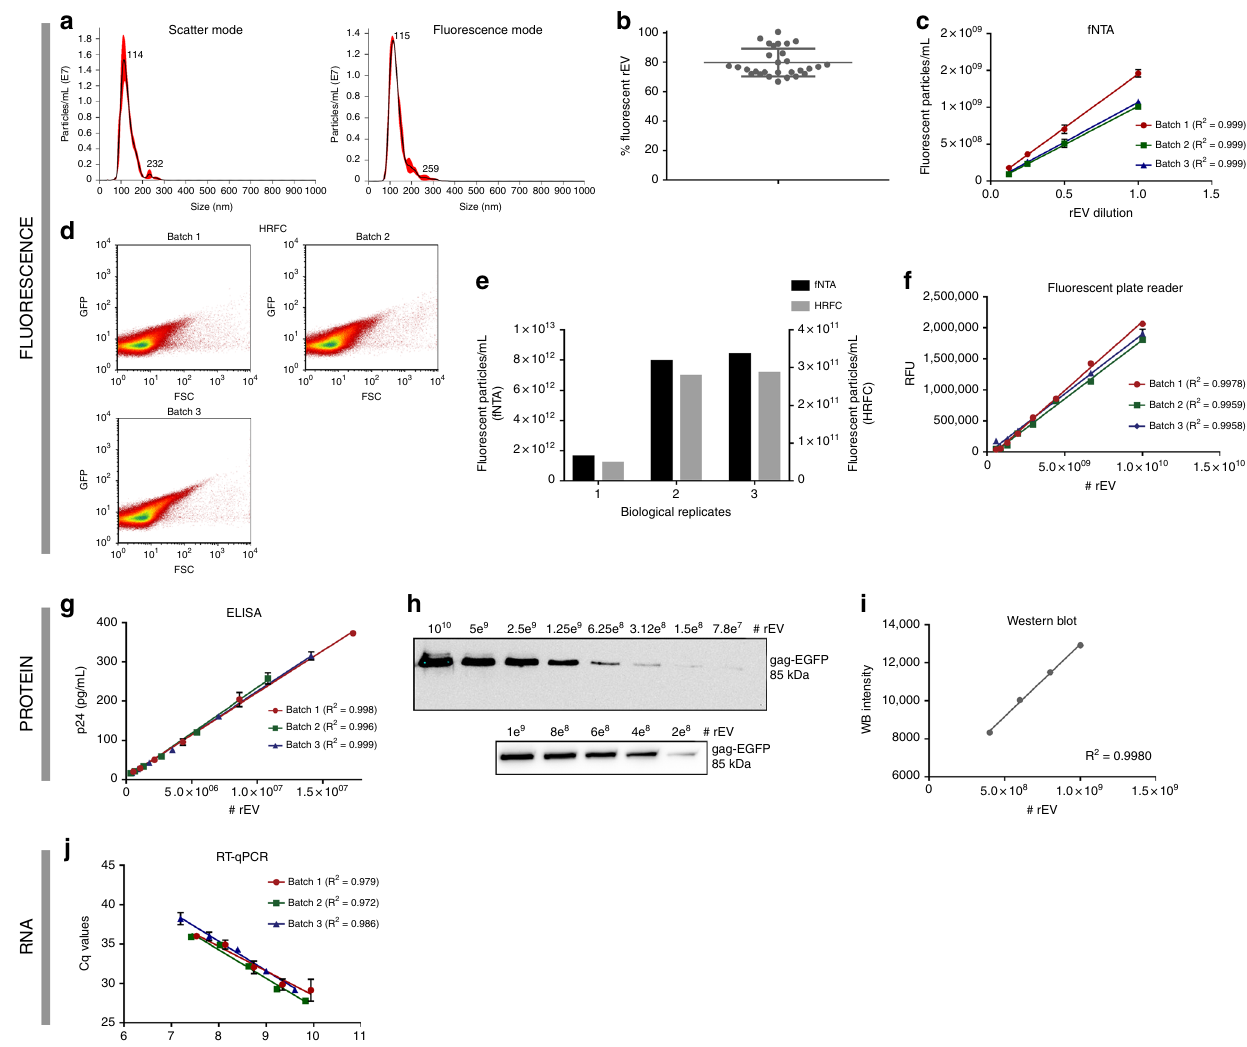
Fig. 3 rEV can be detected and quanti fi ed using fl uorescence-, protein- and RNA-based assays. rEV can be directly quanti fi ed using fl uorescent NTA (fNTA) and fl uorescence triggered high-resolution fl ow cytometry (HR-FC). a Size distributions under both scatter and fl uorescence NTA mode and b the percentage of fl uorescent rEV (ratio fNTA/NTA) detected above detection threshold ( n = 29). c Linear correlation analysis of ½ dilutions of rEV in PBS measured by fNTA ( n = 3). d Scatter plots showing quanti fi cation of rEV with HR-FC ( n = 3). e Relative concentrations of rEV directly quanti fi ed by fNTA versus HR-FC ( n = 3). rEV can be indirectly quanti fi ed using fl uorescent plate reader, p24 ELISA, western blot and RT-qPCR. f Linear correlation analysis of relative fl uorescence units (RFU) measured by a fl uorescent plate reader versus number of rEV ( n = 3). g Linear correlation analysis of p24 concentration measured by a p24 ELISA assay versus number of rEV ( n = 3). h Western blot analysis for EGFP on the maximum detectable concentration range with i linear correlation analysis of protein band intensity versus rEV number. j Semi-logarithmic correlation analysis of EGFP mRNA Cq values calculated by RT-qPCR versus number of rEV ( n = 3) (measurements in c , f , g , j are performed in triplicate and presented as (mean, SD)). Source data are provided as a source data fi